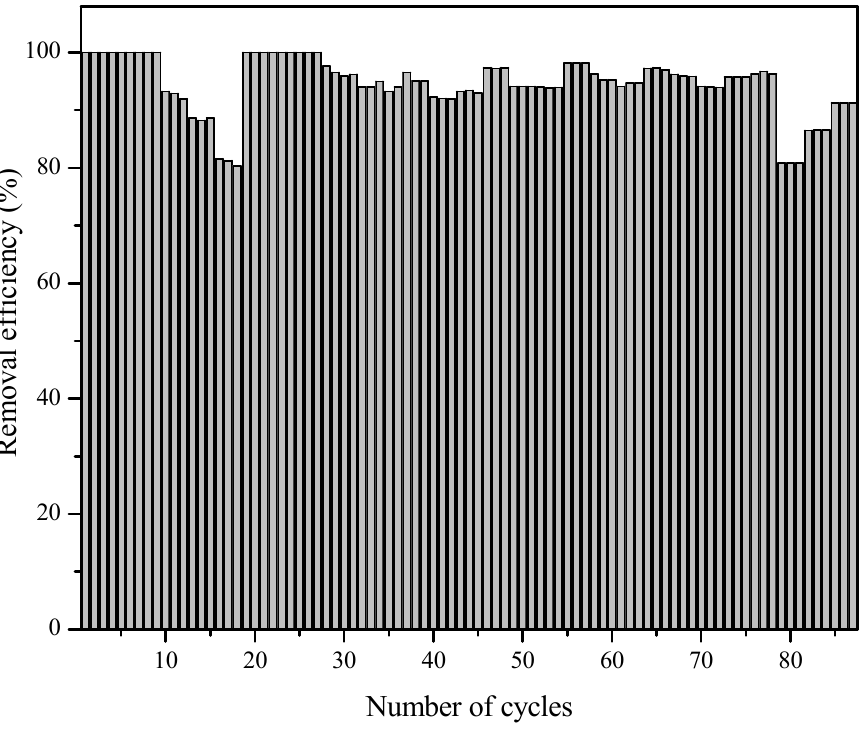
Figure 9. Reusability of the photocatalyst.